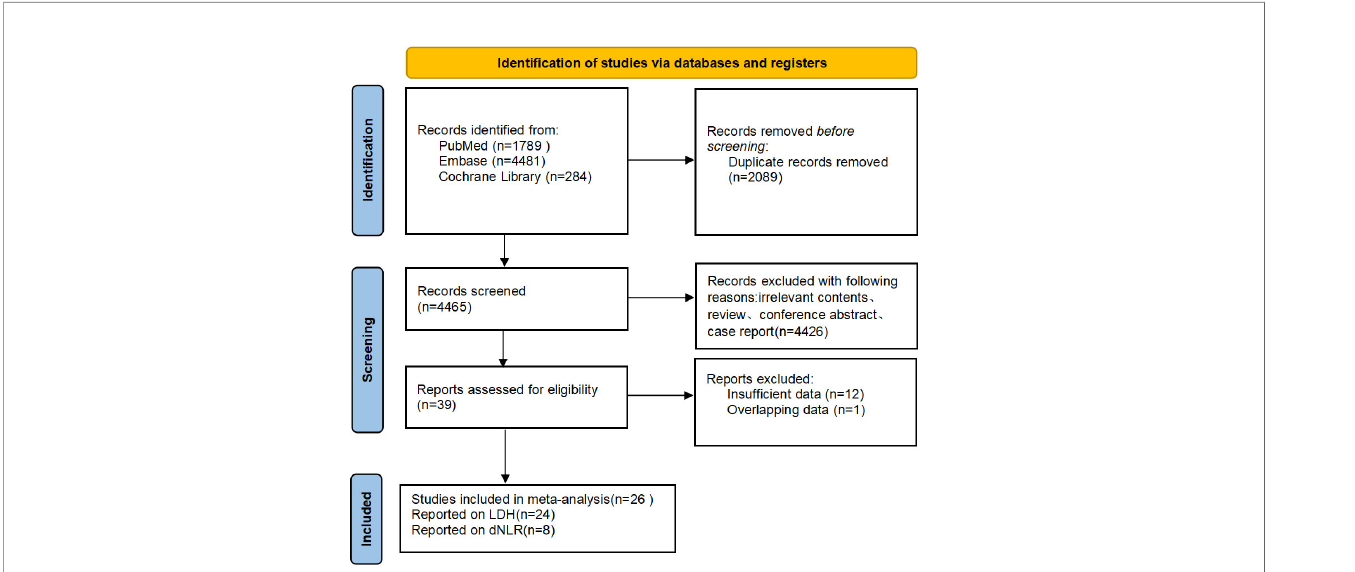
FIGURE 1 | Flowchart of the included